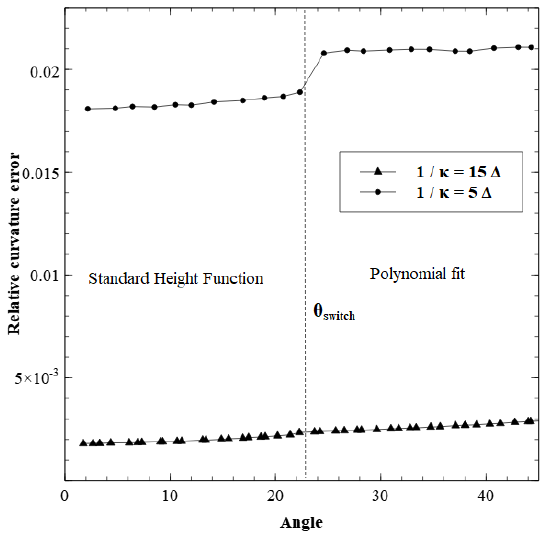
Figure 6. Relative curvature errors along the circular interface as a function of the interface inclination angle with respect to the horizontal for two interface resolutions.